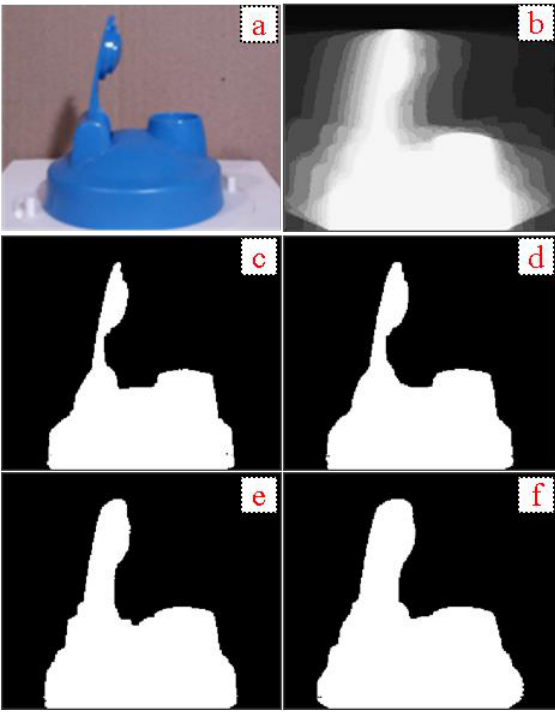
Figure 9. Illustration of the effect of varying thresholds on the object reconstruction. Figure 9 (a) shows the image of the object. Figure 9 (b) is the projected probability map onto the z- Figure 11. A comparison of the reconstruction accuracy for y plane. Figures 9 (c-f) correspond to the threshold values of different thresholds. Figures 11 (a), 11 (b), 11 (c) correspond to 0.96, 0.92, 0.91 and 0.8. the threshold values of 0.91, 0.94, and 0.96. Figure 11 (d) shows the image of the object as the reference. Example images from the second set are shown in Figure 10.